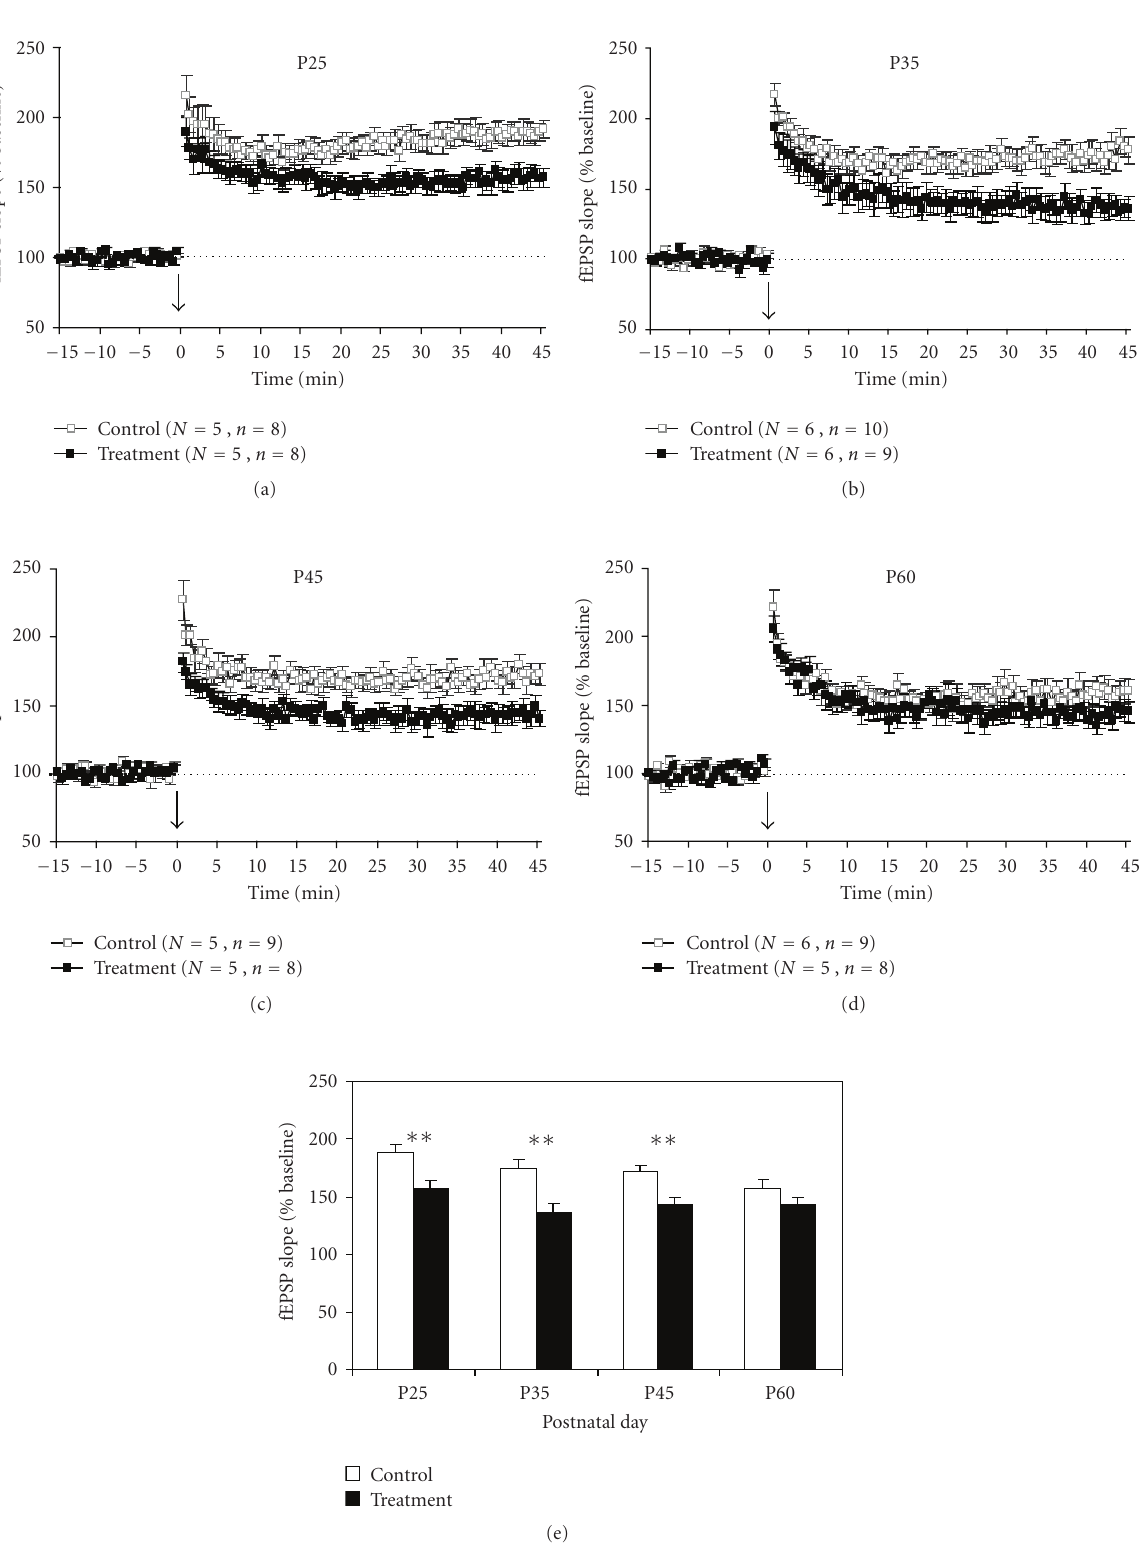
Figure 3: LTP induction in the medial perforant path—dentate gyrus (MPP-DG) pathway in sensorimotor deprived group (treatment) and sham-operated control group (control) at indicated age. (a) PN25, (b) PN35, (c) PN45, (d) PN60. Arrow indicates the time point when conditioning stimulation was administered. Numbers of rats ( N ) and slices ( n ) are indicated in all figures. (e) Summary of LTP induction at PN25, PN35, PN45, and PN60. ∗∗ Indicates a highly significant between group di ff erence for a given age ( P < .